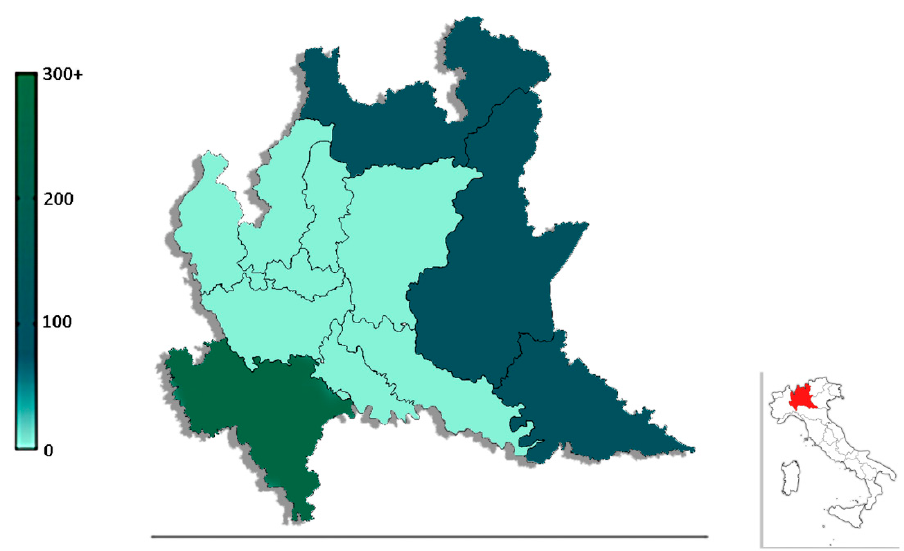
Figure 2. Species abundance of sand flies collected in each province of the Lombardy region.